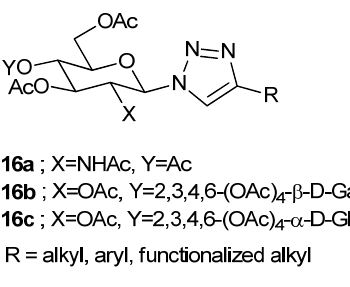
Figure 13. Mono ‐ and di ‐ saccharide derived glycosyl triazoles. Figure 13. Mono- and di-saccharide derived glycosyl